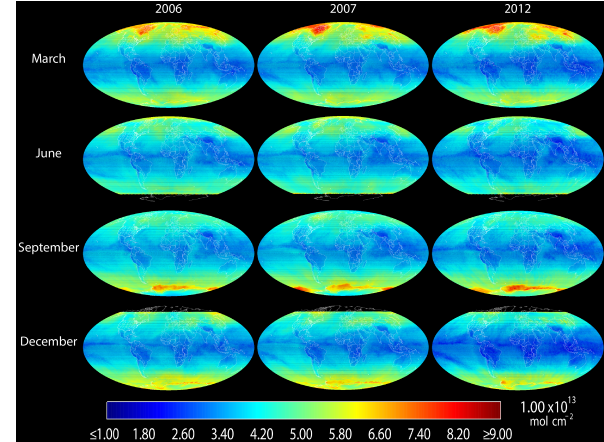
Figure 10. Global distributions of monthly mean BrO VCDs in March, June, September and December (in different rows) of 2006, 2007 and 2012 (different columns). Bromine release “explosions” during the polar spring months can be seen